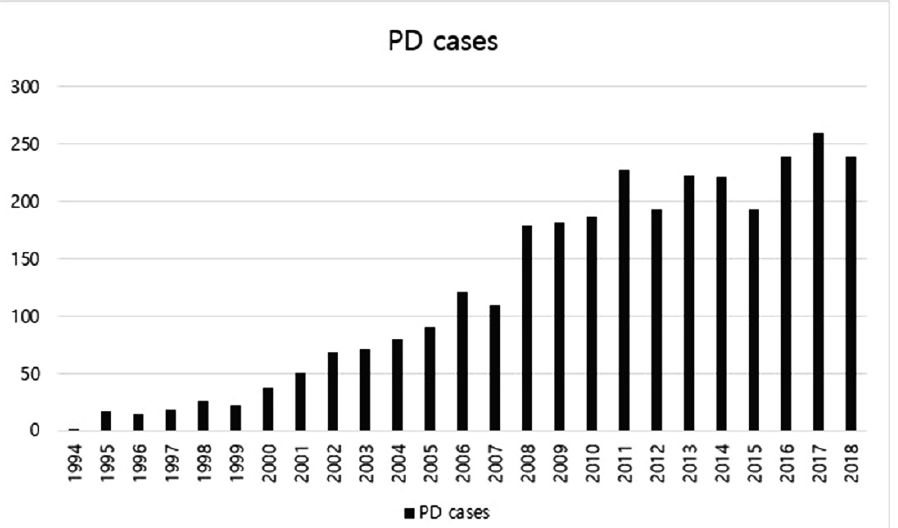
Figure 1. The number of pancreaticoduodenectomy (PD) cases by year from 1994 to 2018.